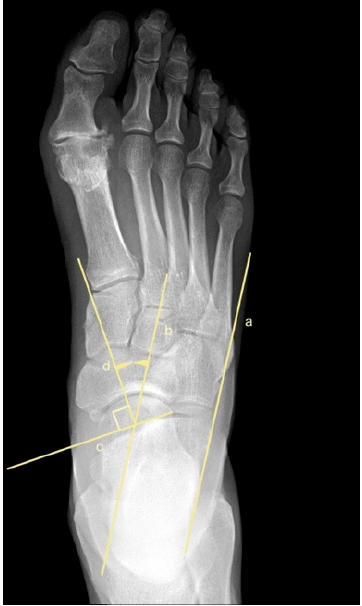
Figure 7. Dorsoplantar weightbearing radiograph of Kite’s angle.